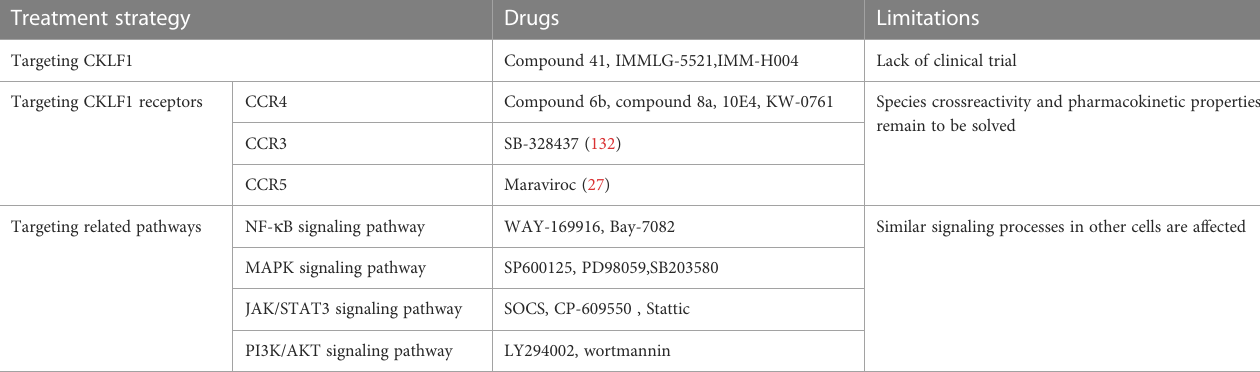
TABLE 2 Treatments against CKLF1